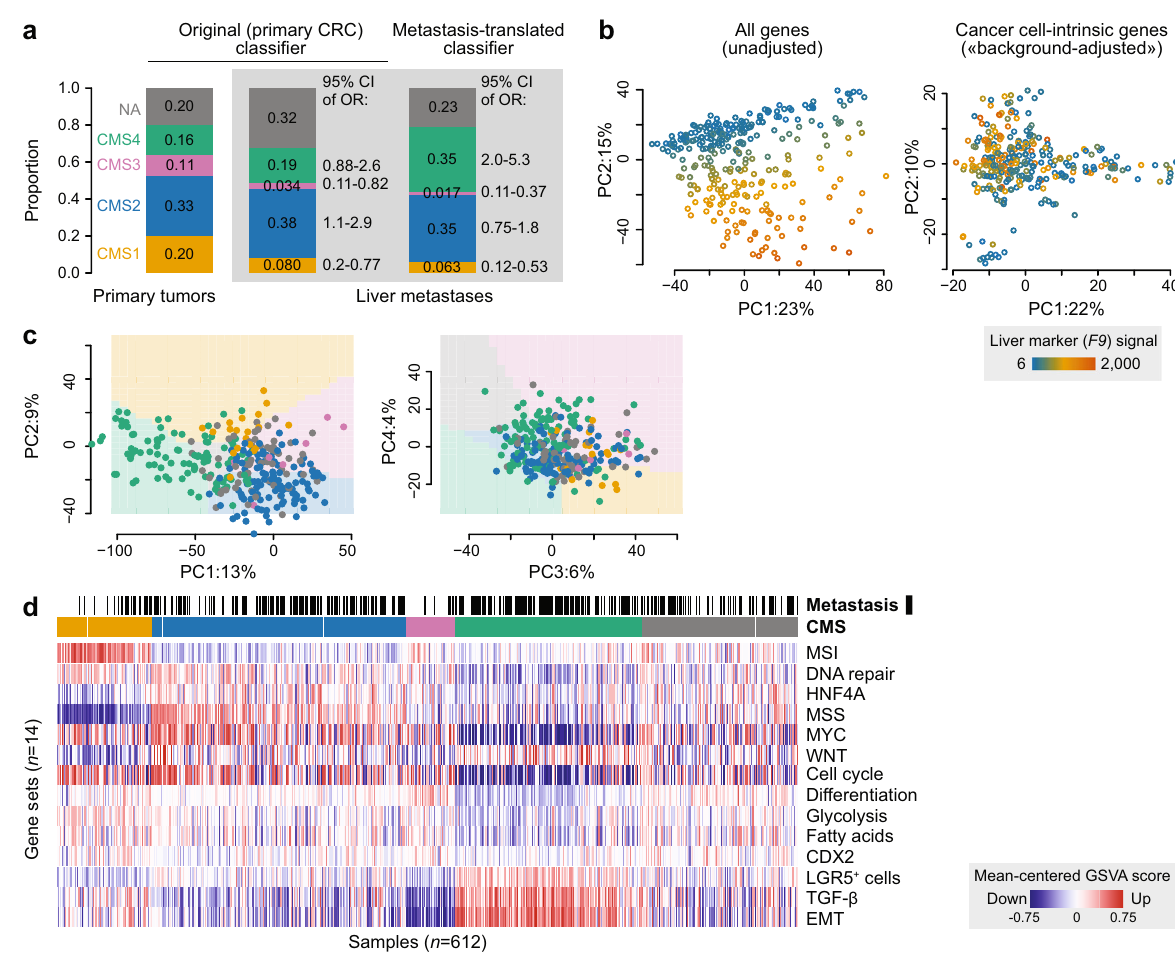
Fig. 2 Translation of CMS classi fi cation to liver metastases. a Barplots illustrate differences in CMS distributions between primary tumors and liver metastases using the original primary CRC classi fi er and the new metastases-translated classi fi er. Odds ratios (ORs) indicate changes in proportions of each CMS compared to the primary setting (only counting con fi dently classi fi ed samples). b Principal component analyses demonstrate that the transcriptomic “ liver background ” (here illustrated by expression of the hepatocyte-enriched F9 gene marker) represents a large source of variation in raw expression data from bulk tissue samples of liver metastases (left), but not when only considering the 1104 cancer cell-intrinsic candidate markers after “ liver background-adjustment ” (right). c Principal component analyses showing CMS-classi fi ed liver metastases (colored dots, n = 295) projected onto the fi rst four principal components from primary tumors. Colored backgrounds represent the dominant subtype in the primary tumors. d Gene set analysis with sample type (black: metastases; white: primary tumors) and assigned CMS (as in a ) indicated on top. Samples are ordered according to CMS and p-values from the tailored CMS classi fi er. Gene sets (in rows) are ordered according to CMS hallmarks (CMS1 characteristics fi rst, followed by CMS2 and so